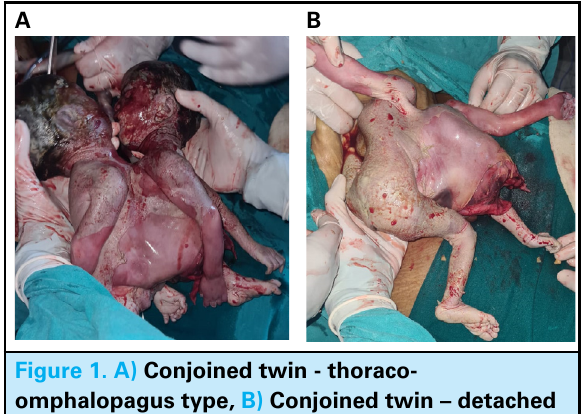
Figure 1. A) Conjoined twin - thoraco- omphalopagus type, B) Conjoined twin – detached one lower limb.